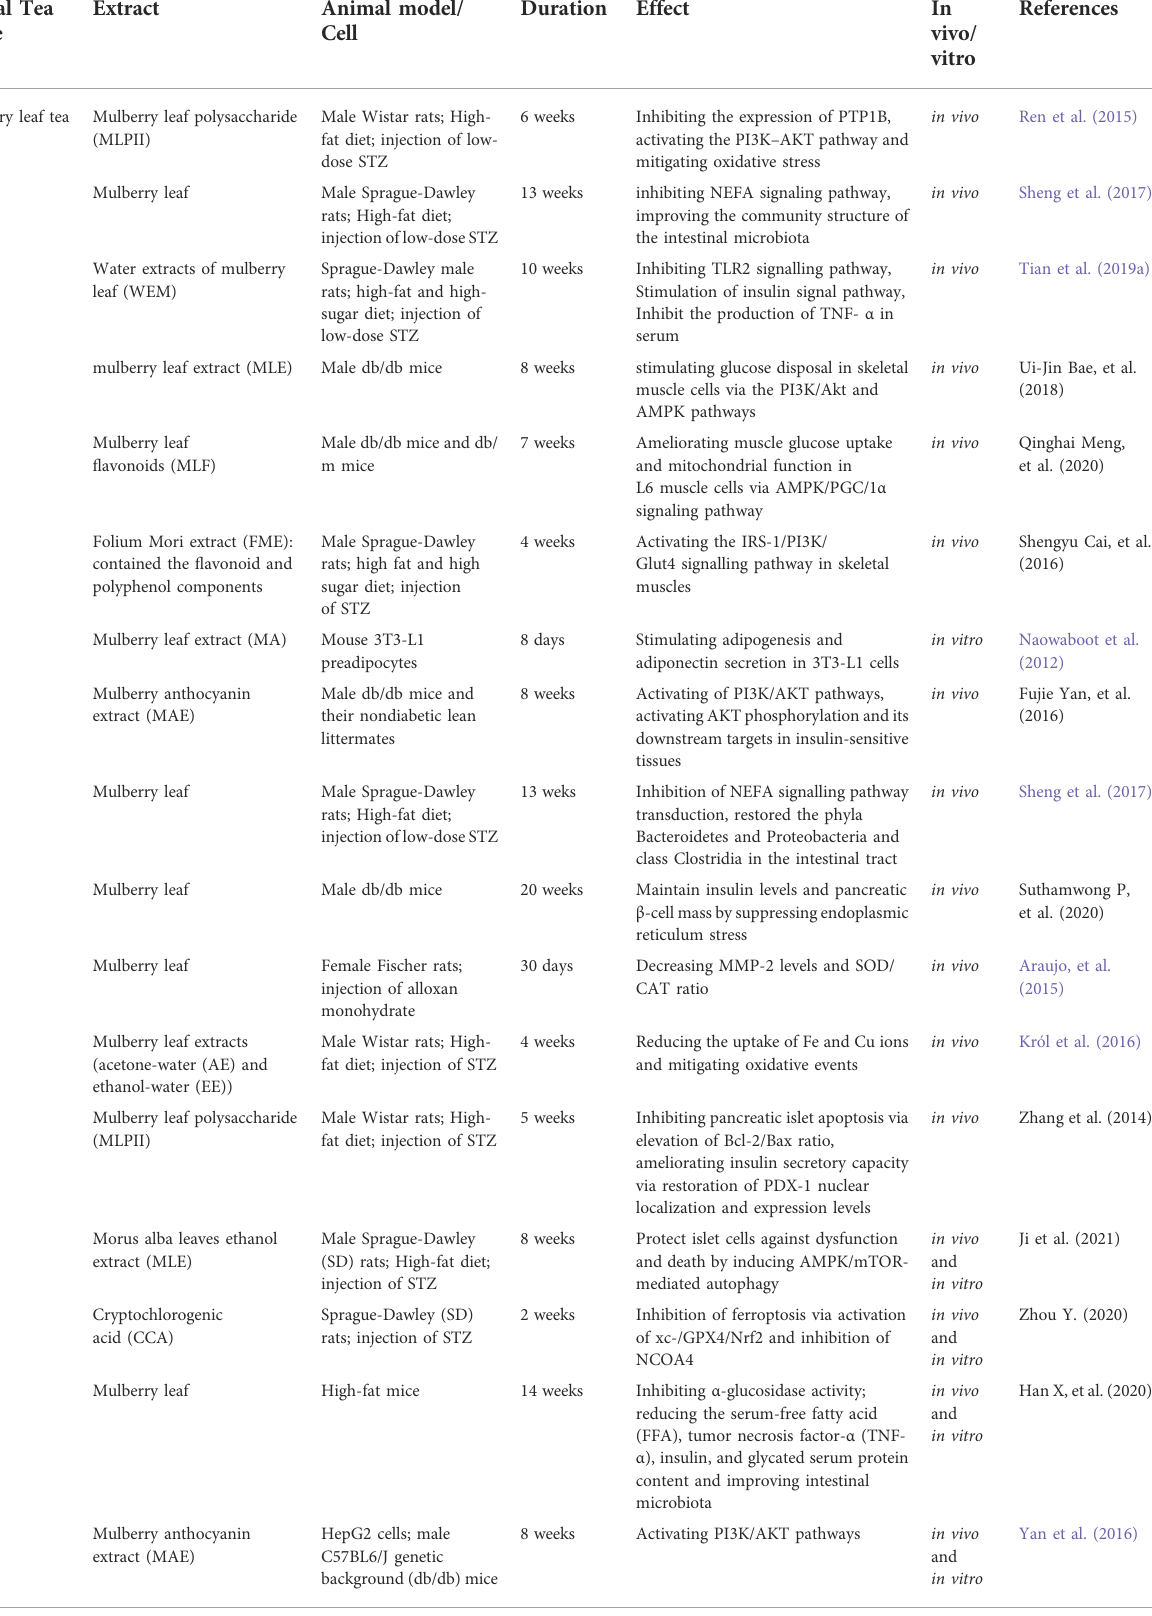
TABLE 5 Hypoglycemic mechanism of herbal tea based on single herbal tea. Herbal Tea